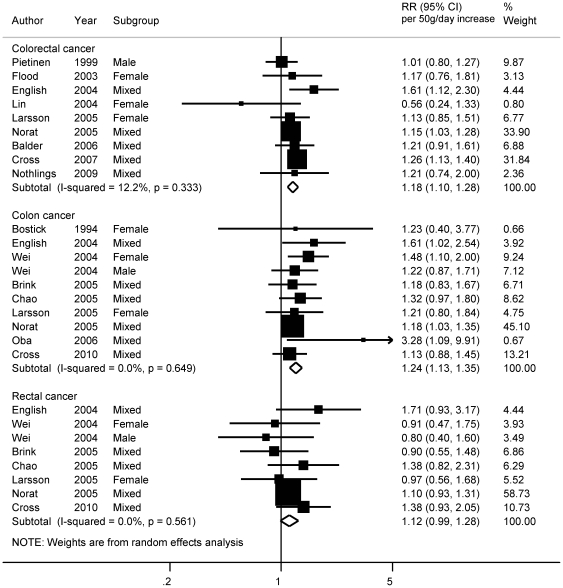
Dose-response meta-analyses of processed meat consumption and the risk of colorectal, colon and rectal cancers.References: Pietinen, 1999 [57]; Flood, 2003 [33]; English, 2004 [60]; Lin, 2004 [56]; Larsson, 2005 [34]; Norat, 2005 [50]; Balder, 2006 [64]; Cross, 2007 [22]; Nothlings, 2009 [26]; Bostick, 1994 [52]; Wei, 2004 [18]; Brink, 2005 [49]; Chao, 2005 [54]; Oba, 2006 [27]; Cross, 2010 [21].